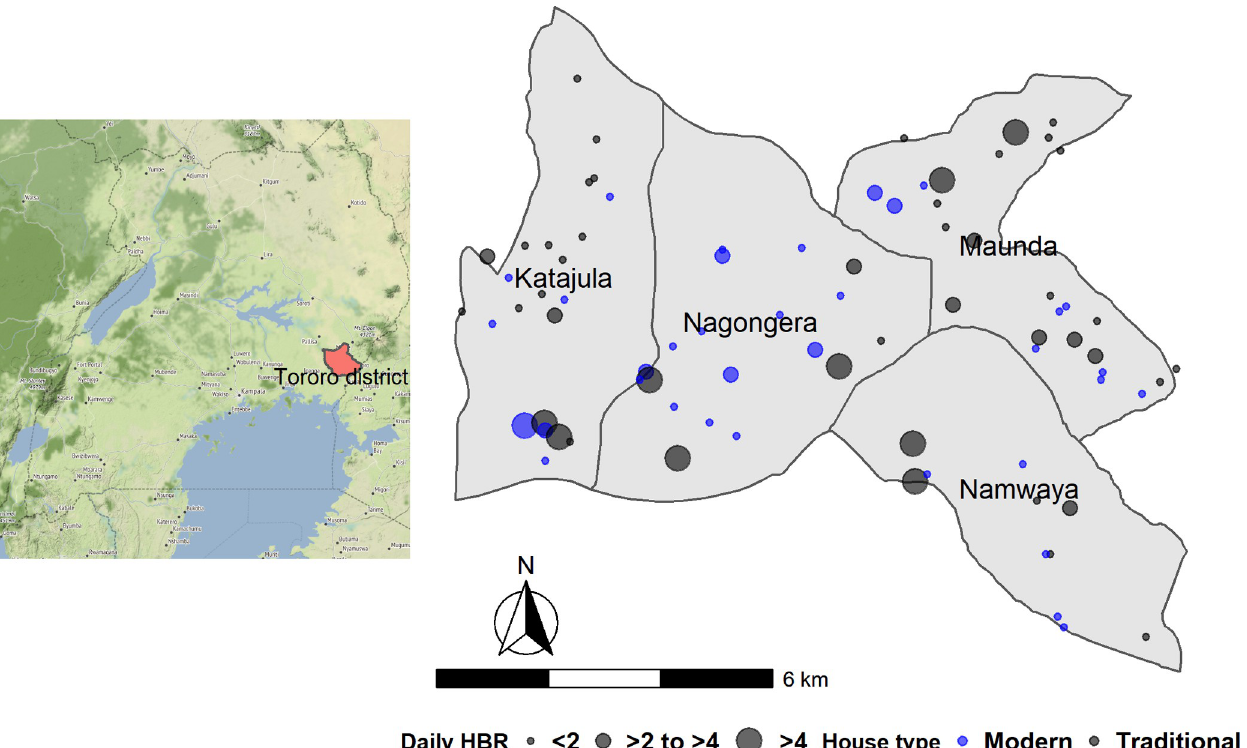
Fig 2. Map of the study area showing distribution of house type and daily human biting rate (base map source: http://maps.stamen.com/).